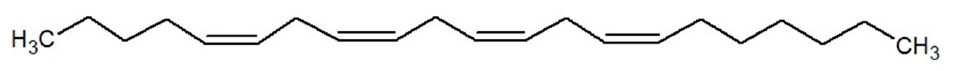
Figure 4. Chemical structure of the new compound 5Z,8Z,11Z,14Z-heneicosatetraene isolated from P. gymnospora P. gymnospora .